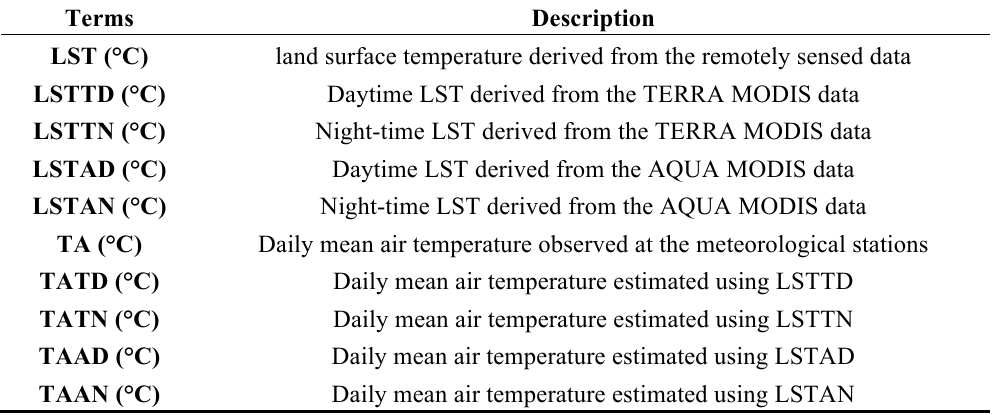
Table 1. Descriptions of the key terminology used in this study. Terms